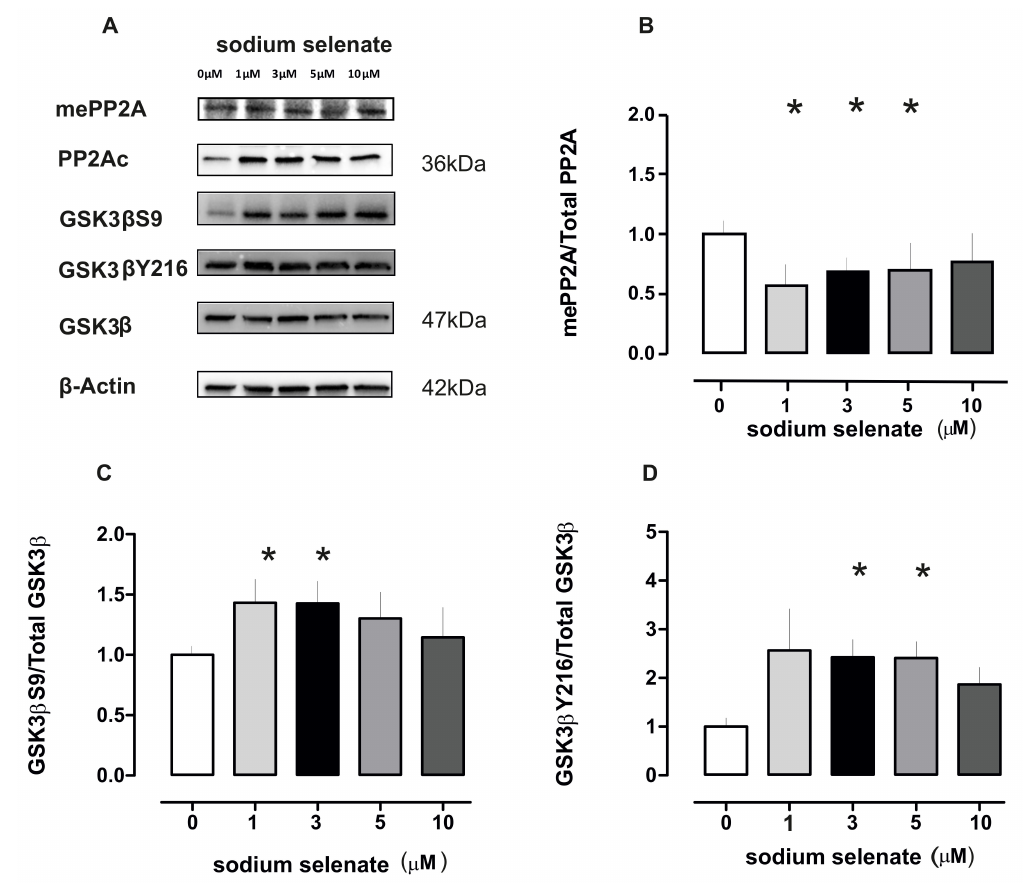
Figure 3. Sodium selenate treatment reduces active PP2Ac (mePP2A) and results in an increase in GSK3 β phosphorylation at both inhibitory S9 and catalytic Y216 sites. ( A ) Immunoblot images of mePP2A, PP2Ac, (both 36 kDa) total GSK3 β , GSK3 β S9, GSK3 β Y216 (all 47 kDa) and loading control β -actin (42 kDa) for the different selenate dose. ( B ) Histogram plot of mePP2A-levels normalized to PP2Ac and β -actin values for different selenate doses. ( C ) Histogram plot of GSK3 β S9/total GSK3 β after different selenate doses. ( D ) Histogram plot of GSK3 β Y216/ total GSK3 β after different selenate doses (in all plots asterisk p <